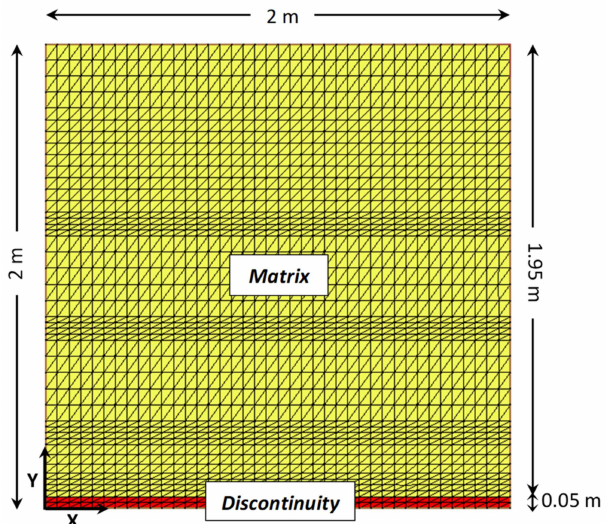
Figure 2. Finite element mesh of the 2-D reactive transport